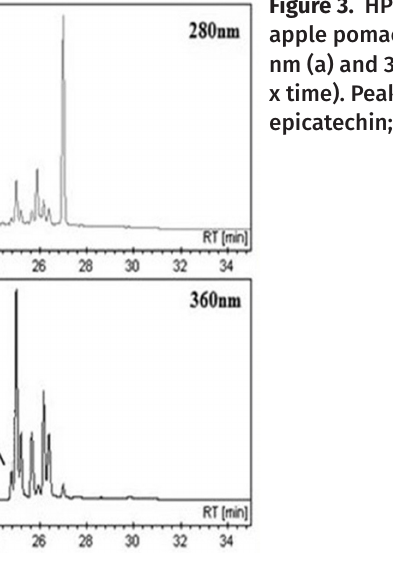
Figure 3. HPLC profile of apple pomace extract at 280 nm (a) and 360 nm (b) (mAU x time). Peaks: 1. catechin; 2. epicatechin; 3 .